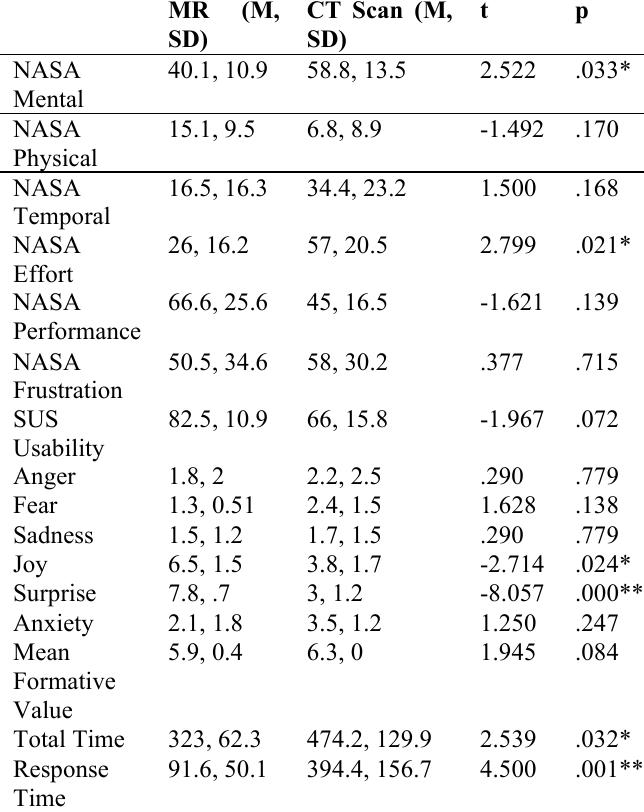
Table 1. Independent samples